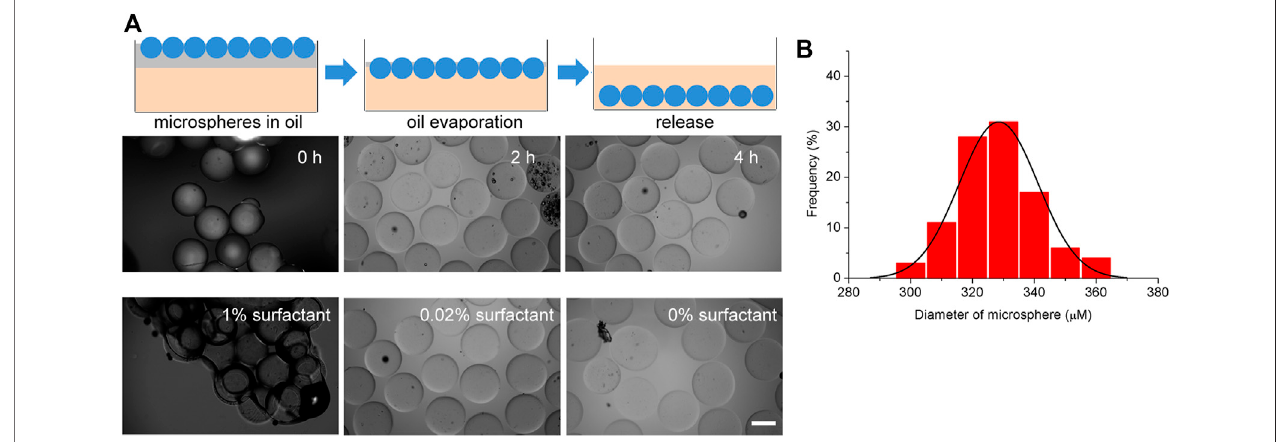
FIGURE 3 | Generation and extraction of hydrogel microspheres. (A) Schematic diagram of the microsphere extraction process by oil evaporation. (B) Size distribution of the hydrogel microspheres. (C) Representative microscopy image of extraction process. The scale bar represents 200 µm.